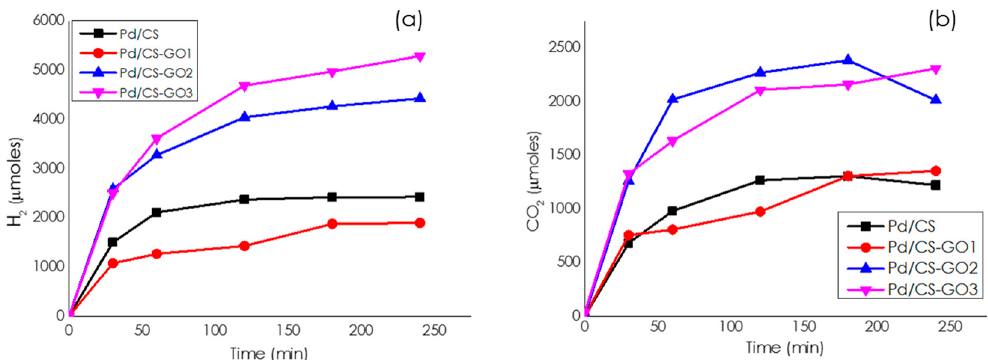
Figure 8. Temporal profiles of H 2 ( a ) and CO 2 ( b ) evolution in the gas phase for the decomposition of NH 4 HCO 2 catalyzed by Pd/CS, Pd/CS-GO1, Pd/CS-GO2, and Pd/CS-GO3. Reaction conditions: 10 mmoles of ammonium formate, 10 mL of methanol, 60 °C, and 11.75 µmoles of Pd.